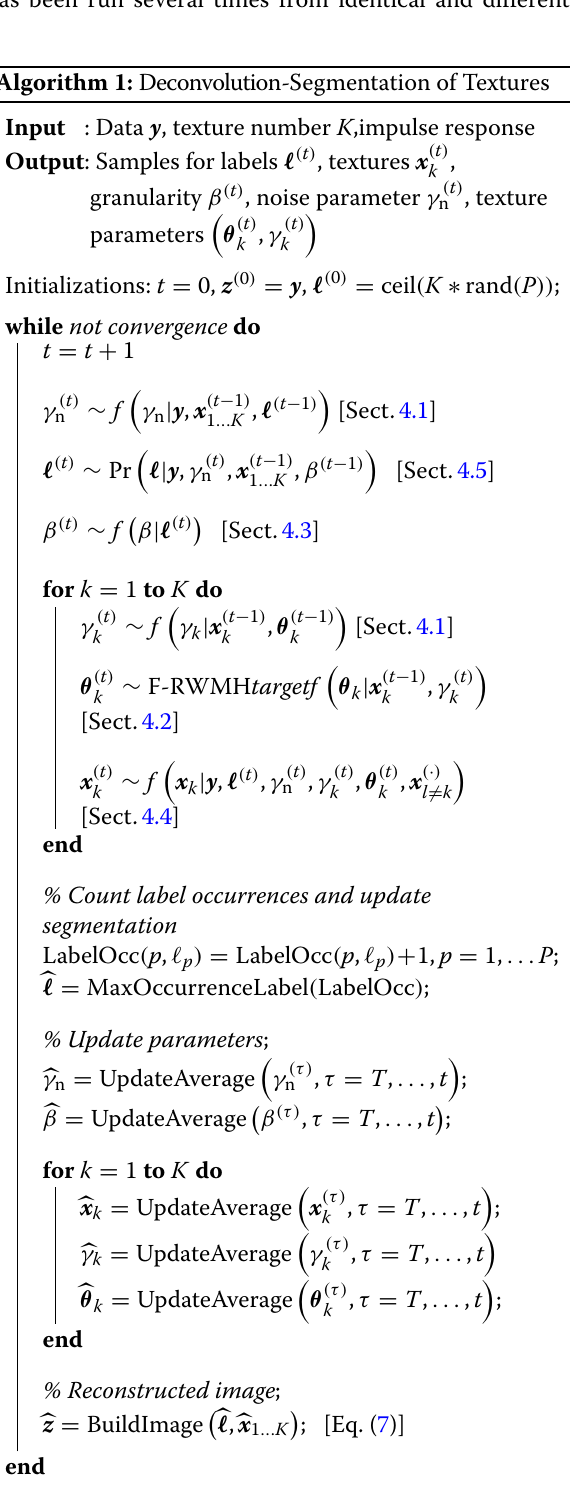
Table 1 The horizontal and vertical frequencies ν 0 respectively given in the top and the bottom part of the table.